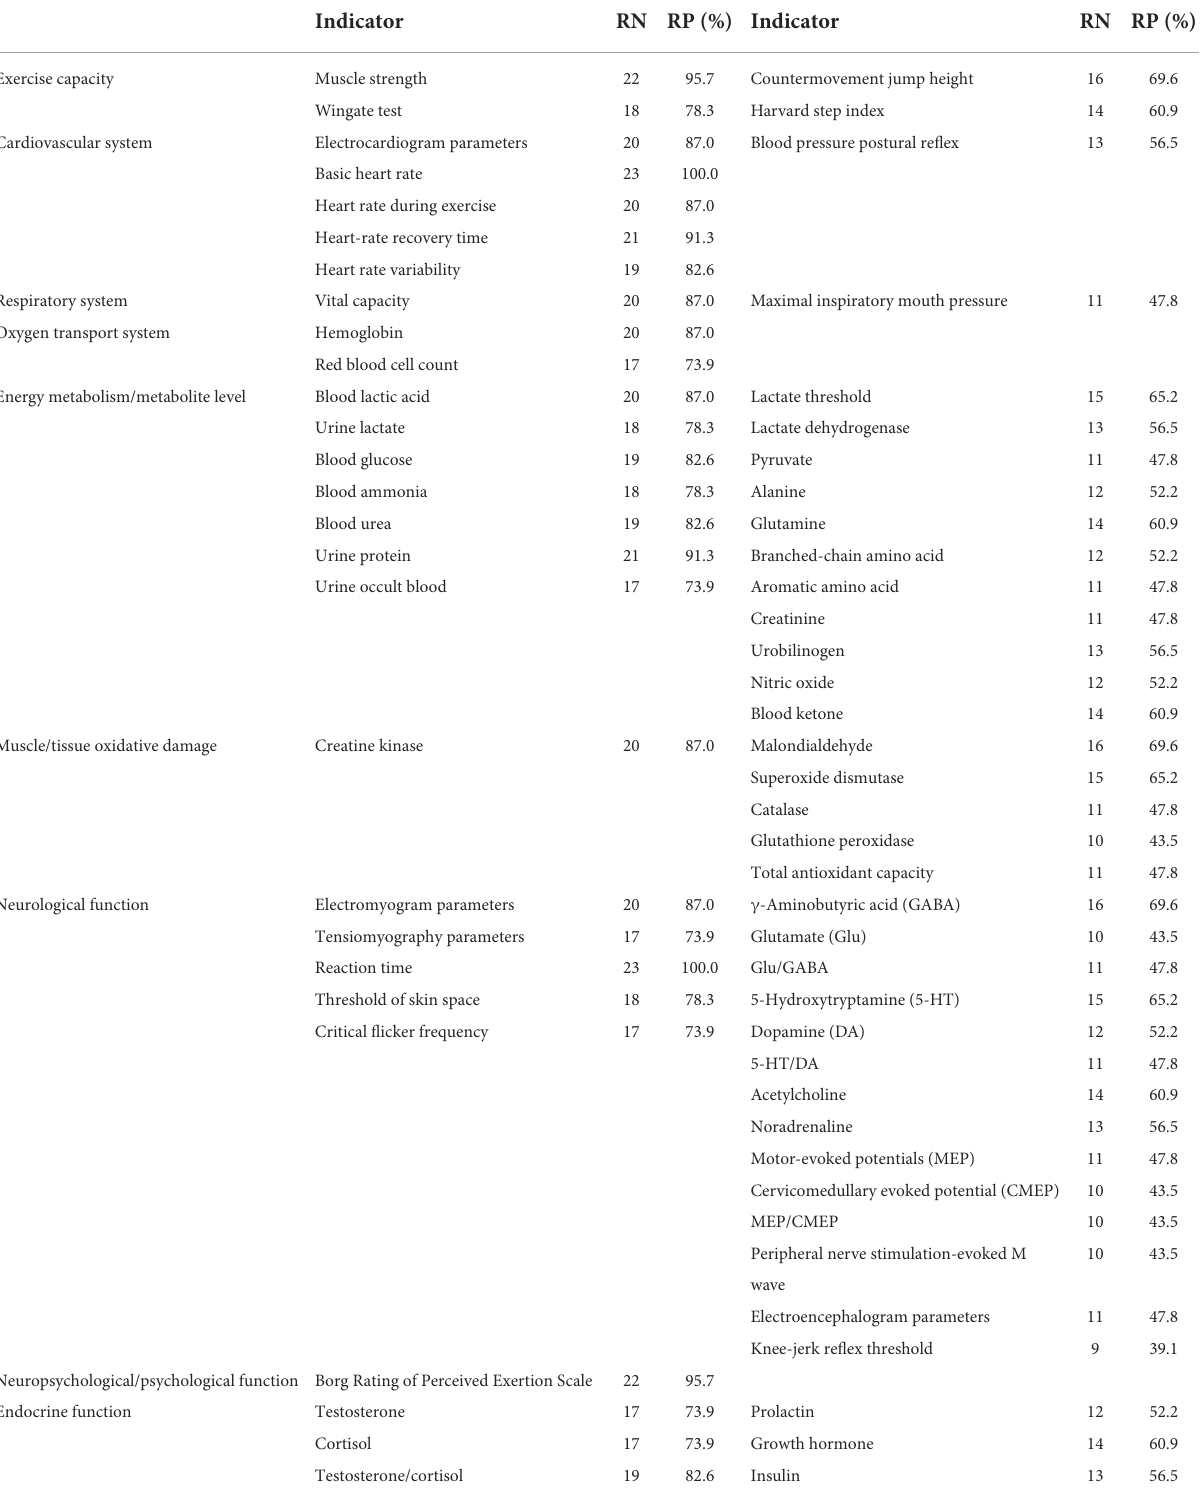
TABLE 3 Results of Delphi round